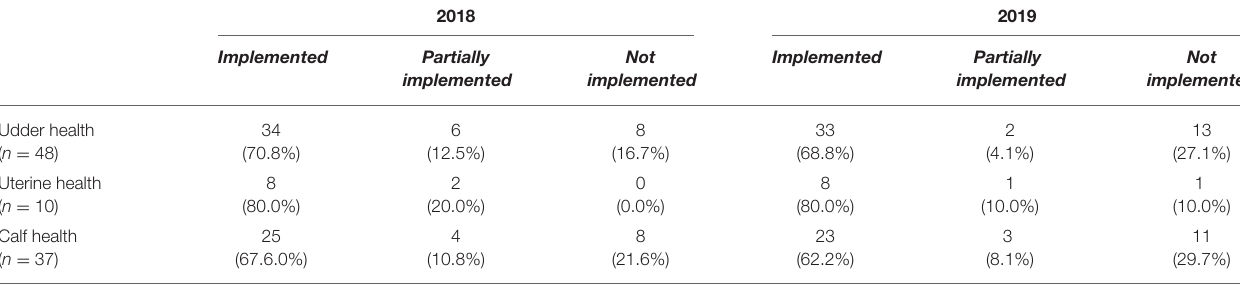
TABLE 3 | Number of farmers ( n = 50) who implemented the prevention strategies in 2018 and 2019.